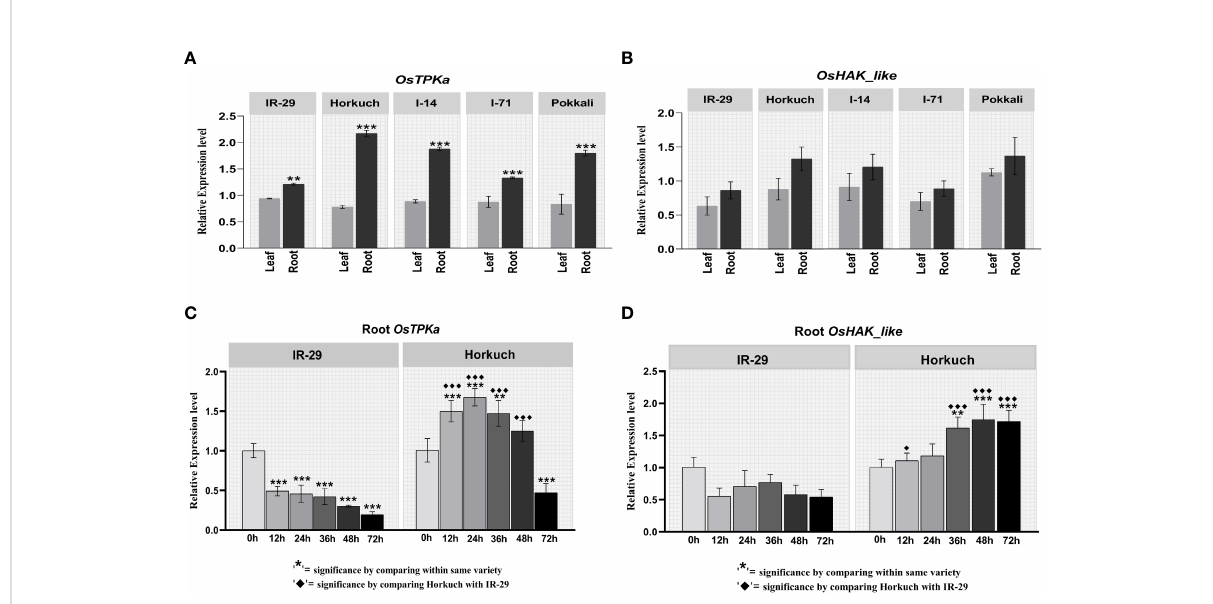
FIGURE 1 Differential expression analysis of OsTPKa and OsHAK_like by Real-Time quantitative PCR. (A, B) tissue speci fi c expression analysis in IR29, Horkuch, I-14, I-71 and Pokkali at 24 hour under 150 mM salt-stress; (C, D) Salt-responsive genotype speci fi c expression analysis in root of IR29 and Horkuch at 12 hour, 24 hour, 36 hour, 48 hour and 72 hour under 150 mM stress